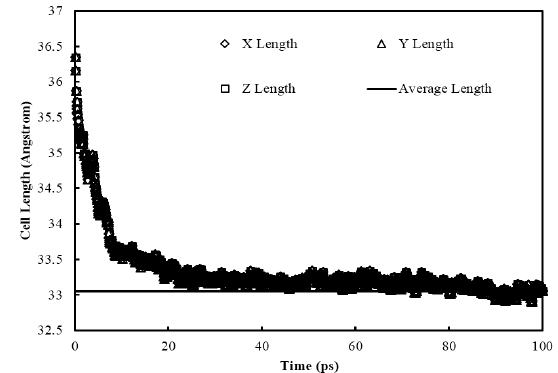
Figure 2. Kerogen model: ( a ) 3D model and ( b ) pore size distribution.